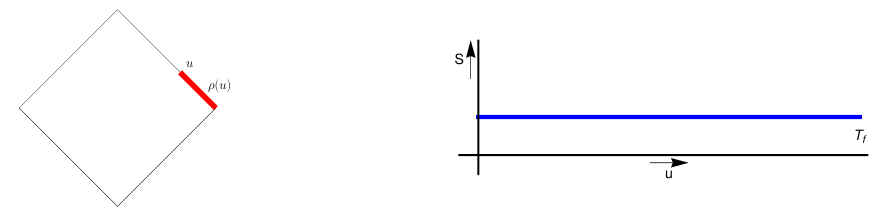
+ is expected to I